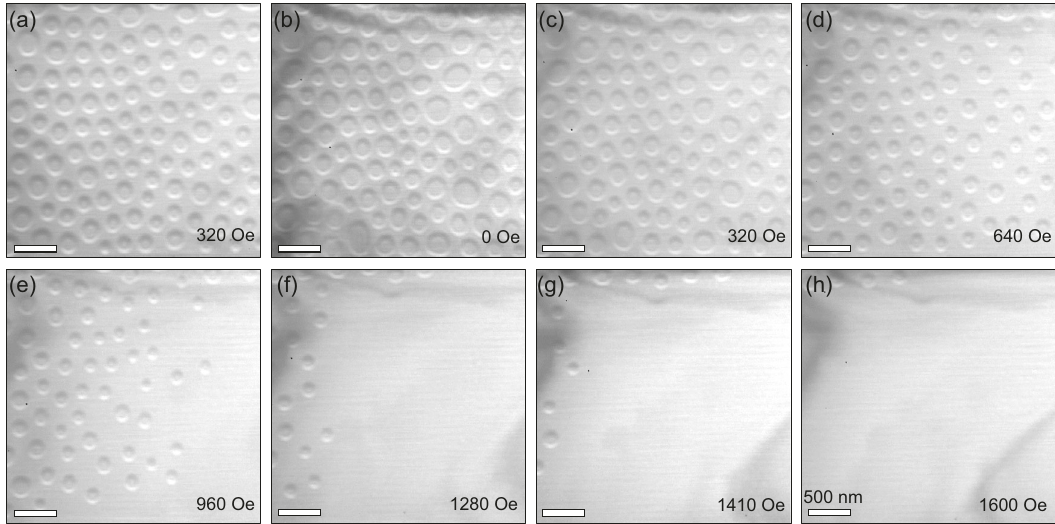
Fig. 4 Evolution of Néel-type textures in a thin lamella of Cr 1 + δ Te 2 as a function of magnetic fi eld at 100K. a – h Lorentz transmission electron microscopy images of Néel-type textures collected at different magnetic fi elds by tilting the lamella 7° away from the [01 (cid:1) 11] direction. These images are acquired at a defocus value of − 1.2 mm. The lamella has a thickness of ≈ 75 are larger in region II than in region I. With increasing magnetic fi eld, skyrmions fi rst disappear at 1280 Oe from region I, while they are still stable within region II, i.e. the skyrmions are con- siderably more stable within the thicker region until, at a fi eld strength beyond 2048 Oe, all skyrmions have completely been transformed into the fi eld-polarized state. Although in both regions the magnetic objects appear simultaneously under the same magnetic fi eld, their disappearance at a different magnetic fi eld points to a signi fi cant thickness dependence of their stability window. In general, the diameter of skyrmions decreases with increasing fi eld. The relation between skyrmion diameter and applied fi eld within both regions is shown in Fig. 5c. An